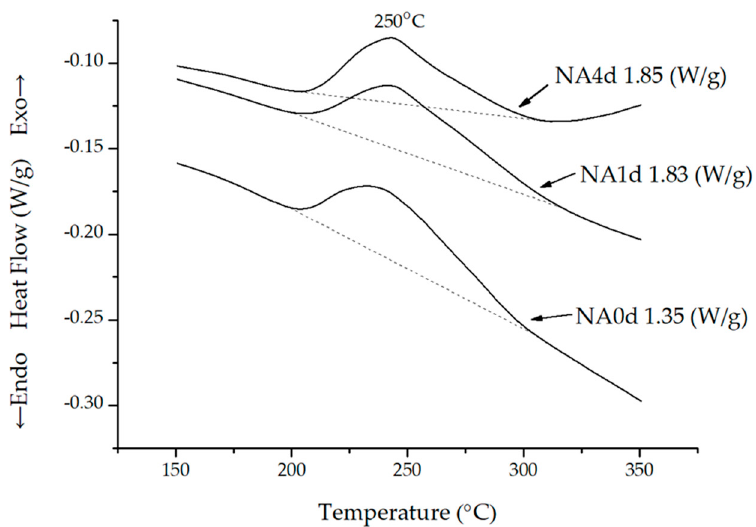
Figure 1. Di ff erential scanning calorimetry (DSC) profile of di ff erent naturally aged A201 alloys. Figure 1. Differential scanning calorimetry (DSC) profile of different naturally aged A201 alloys .